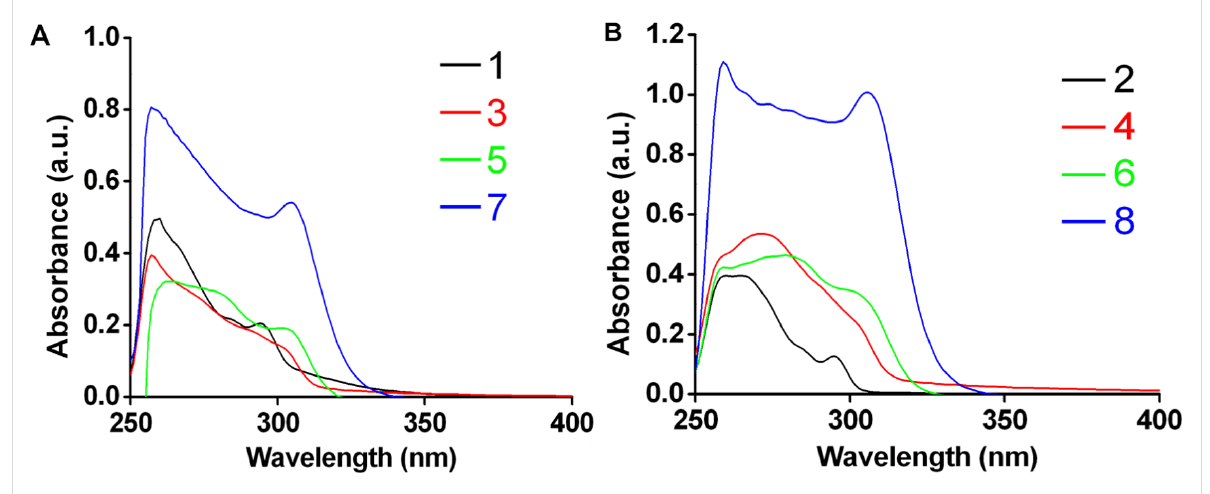
Figure 5: UV–vis absorption spectra of (A) 2,6,14-trisubstituted triptycene derivatives 1 , 3 , 5 and 7 in DMSO (15 μ M) at 298 K; (B) 2,7,14-trisubsti- tuted triptycene derivatives 2 , 4 , 6 and 8 in DMSO (15 μ M) at 298 K.